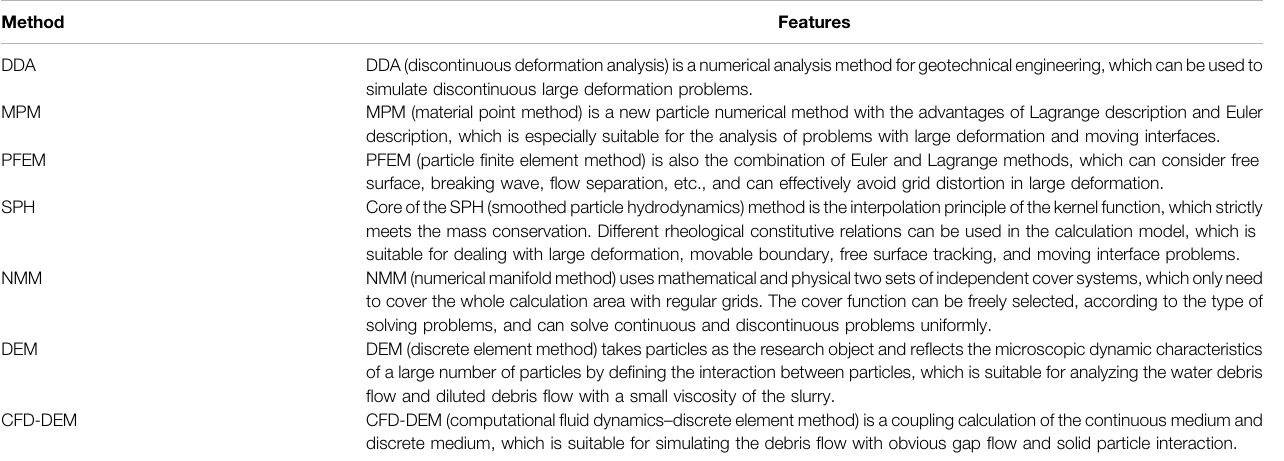
TABLE 3 | Some new numerical simulation methods in recent